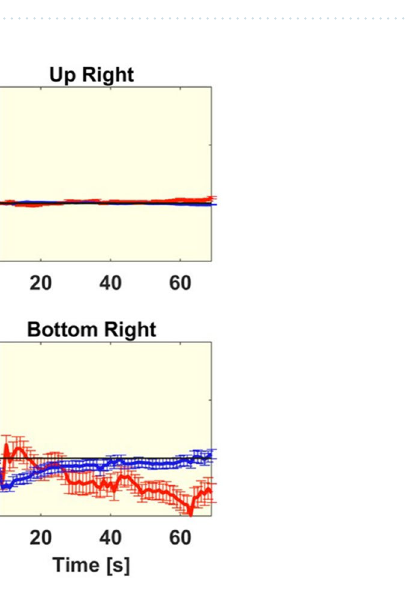
Figure 3. Same as Fig. 2 but group-average of the move group (sheep were moving during and after the 3 s startling stimulus).